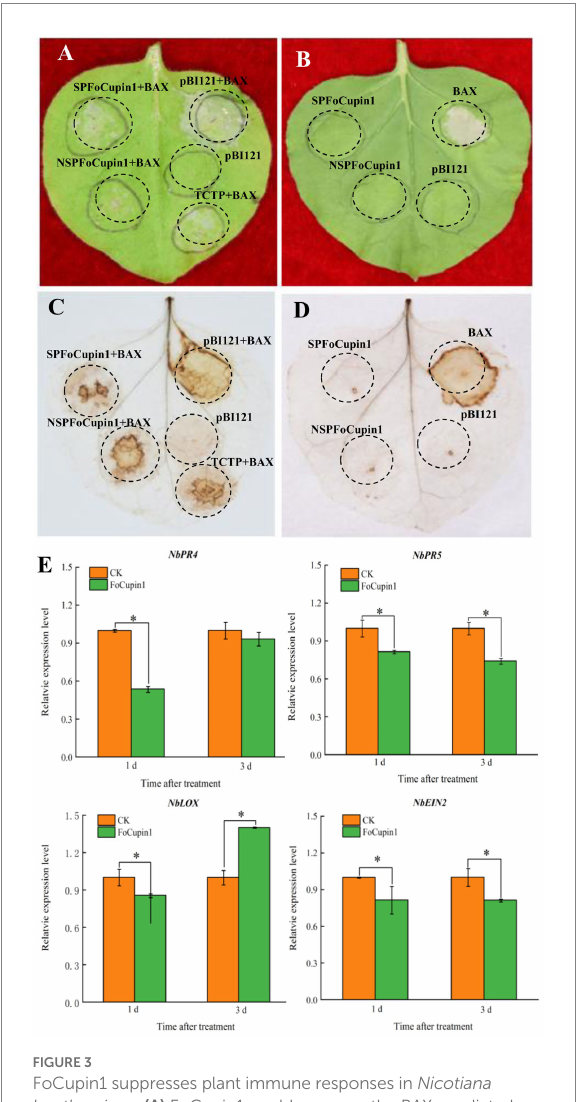
FIGURE 3 FoCupin1 suppresses plant immune responses in Nicotiana benthamiana. (A) FoCupin1 could suppress the BAX-mediated cell death in N. benthamiana leaves. Tobacco leaves were infiltrated with Agrobacterium tumefaciens expressing SPFoCupin1, NSPFoCupin1, TCTP (as positive control), or pBI121 empty vector (as negative control) 2 days before infiltration with A. tumefaciens expressing BAX. The cell death was photographed 3–4 days after infiltration. (B) FoCupin1 could not induce the cell death in N. benthamiana leaves. (C) Reactive oxygen species (ROS) accumulation in (A) were detected by DAB staining. (D) ROS accumulation in (B) were detected by DAB staining. (E) RT-qPCR analysis of four defense-related genes after infiltration with A. tumefaciens expressing FoCupin1. Values are the means (±SE) based on three independent experiments and bars indicate standard deviations. Asterisks indicate statistical significance ( p < 0.05) using Student’s t -test.